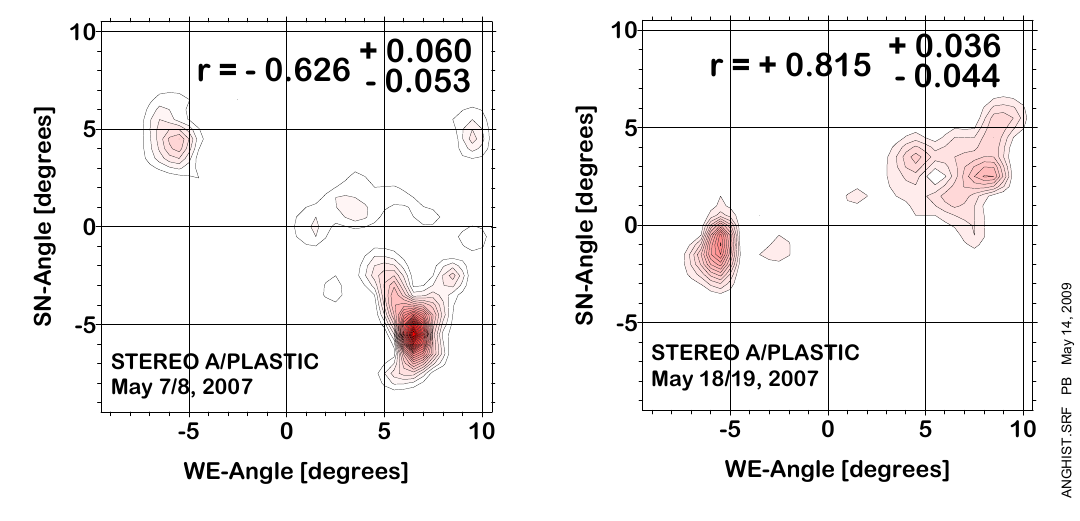
Fig. 3. Correlograms of deflection angles between the forward and reverse shocks of the CIR of 7/8 May 2007 (left panel), and between the forward and reverse pressure waves of the CIR of 18/19 May 2007 (right